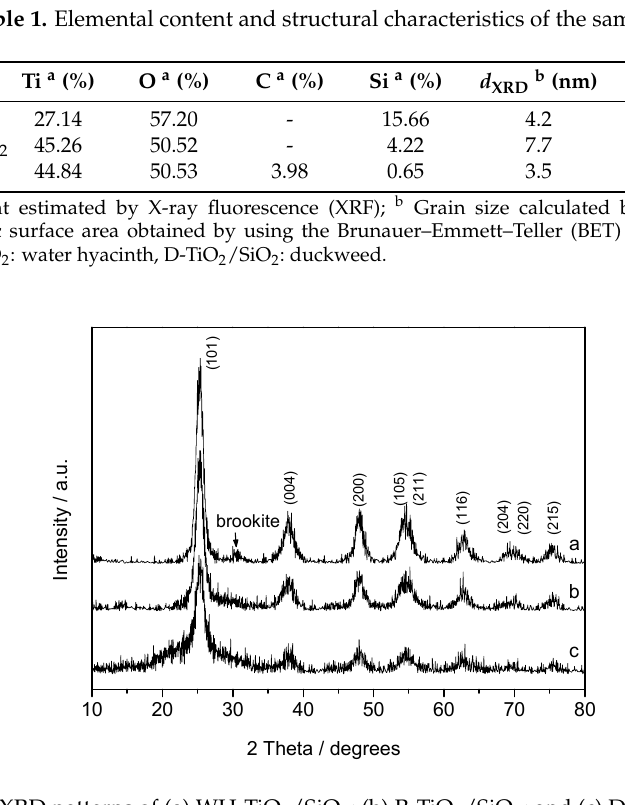
Figure 1. XRD patterns of (a) WH-TiO 2 /SiO 2 ; (b) R-TiO 2 /SiO 2 ; and (c) D-TiO 2 /SiO 2 .